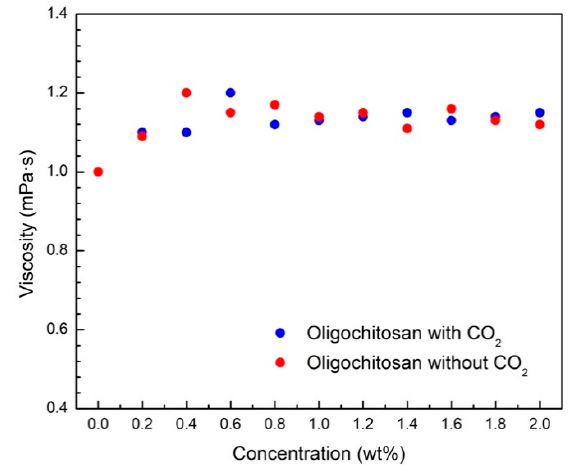
Figure 4. Reversible stability of emulsion of crude oil and aqueous solution. The aqueous solution (5 mL) contains SDS (0.012 mol·L − 1 ) and oligochitosan (0.2 wt.%). The original emulsion (left) is stable and oligochitosan does not spoil its stability. The phase separation appears with the addition of CO 2 (center). However, a stable emulsion is reformed after sparging N 2 and hand shaking (right).